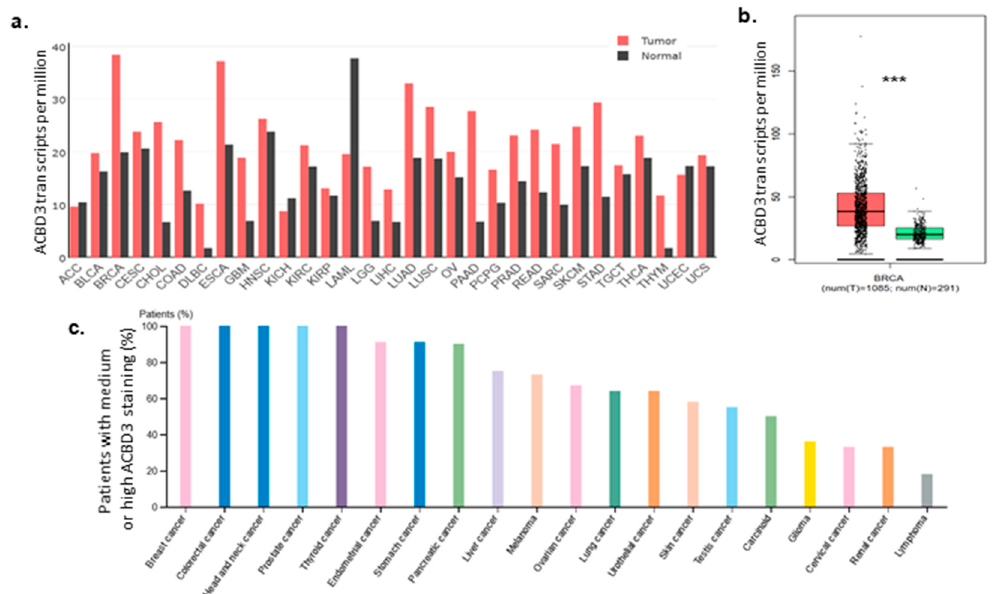
Figure 1 . ACBD3 mRNA and protein expression in cancers. ( a ) Median ACBD3 mRNA expression in transcripts per million in different tumours and matched normal tissue [35]. ( b ) ACBD3 mRNA in breast tumour samples (red) and paired normal breast tissue (green) (*** p = < 0.001, Log 2 FC cutoff = 0.75). ACBD3 expression was 93.06% higher in cancerous breast tissue and samples also had a larger range of expression than normal tissue. ( c ) Protein levels of ACBD3 in cancers, measured by medium or high antibody staining as a percentage of total patient samples.